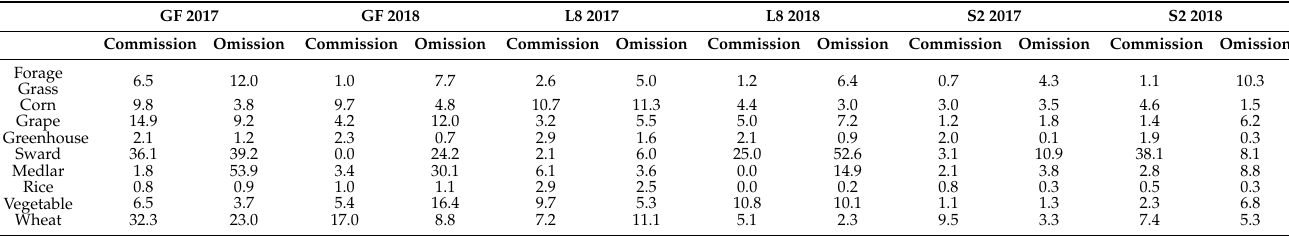
Table 6. Commission and Omission errors for all crop